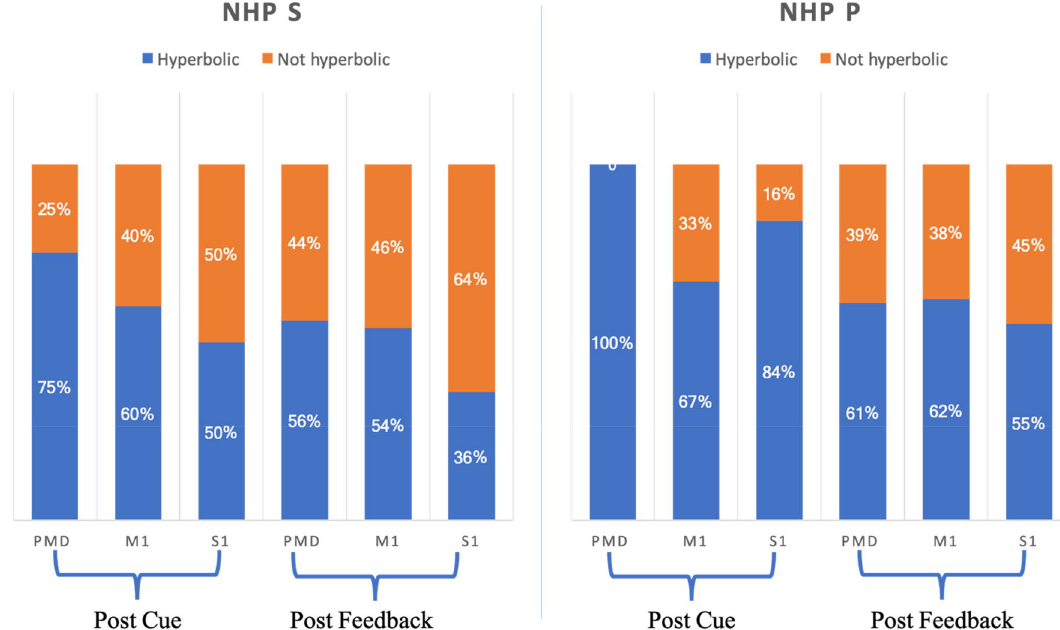
Figure 4. Number of significant units from model 2 that were hyperbolic.